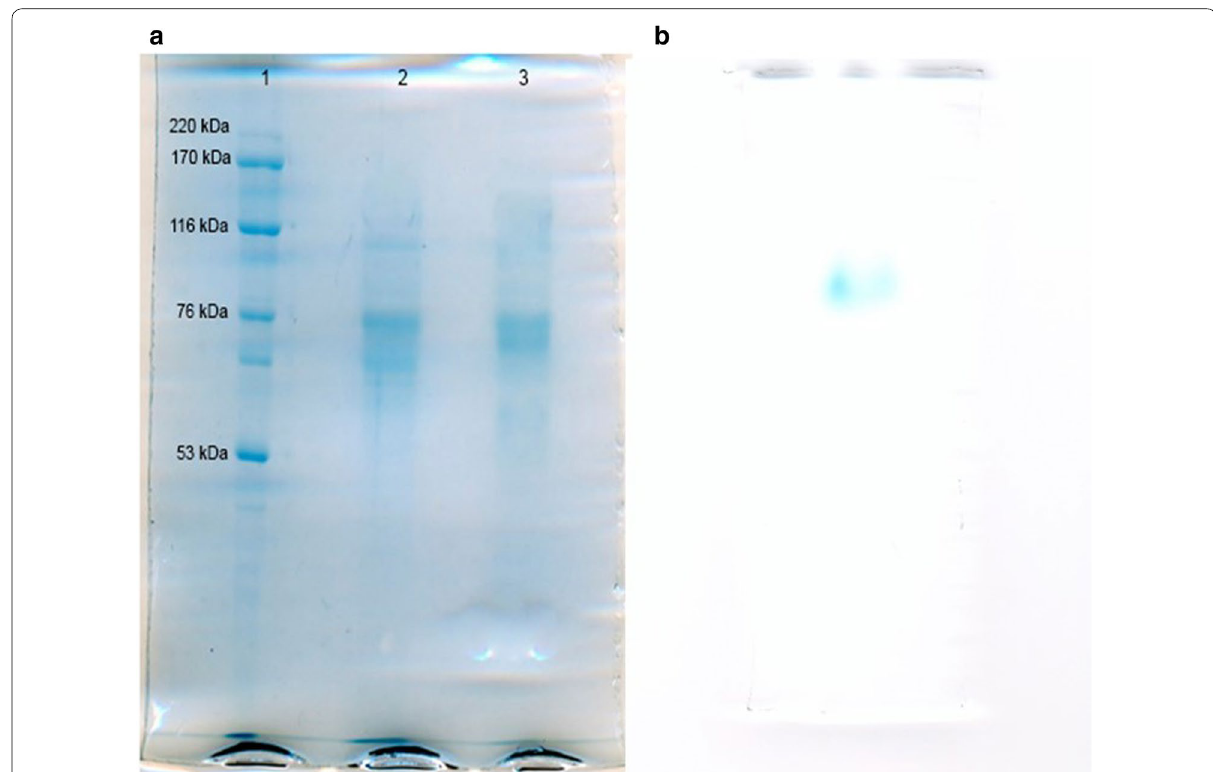
Fig. 4 a SDS‑PAGE of partially purified β‑galactosidase. Lane 1: Molecular mass markers, mass indicated alongside. Lane 2: S‑200 peak. Lane3: DEAE peak. b β‑galactosidase activity zymogram from DEAE